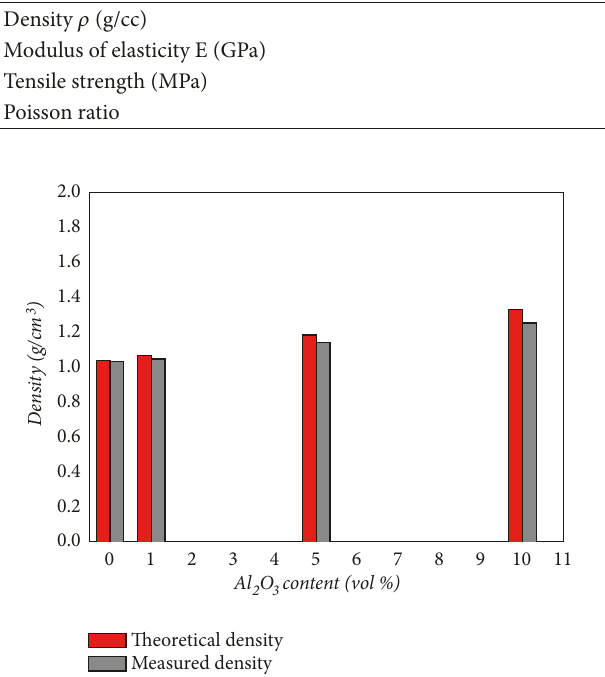
Figure 4: Plot of theoretical and experimental densities of the polyester/alumina composites.